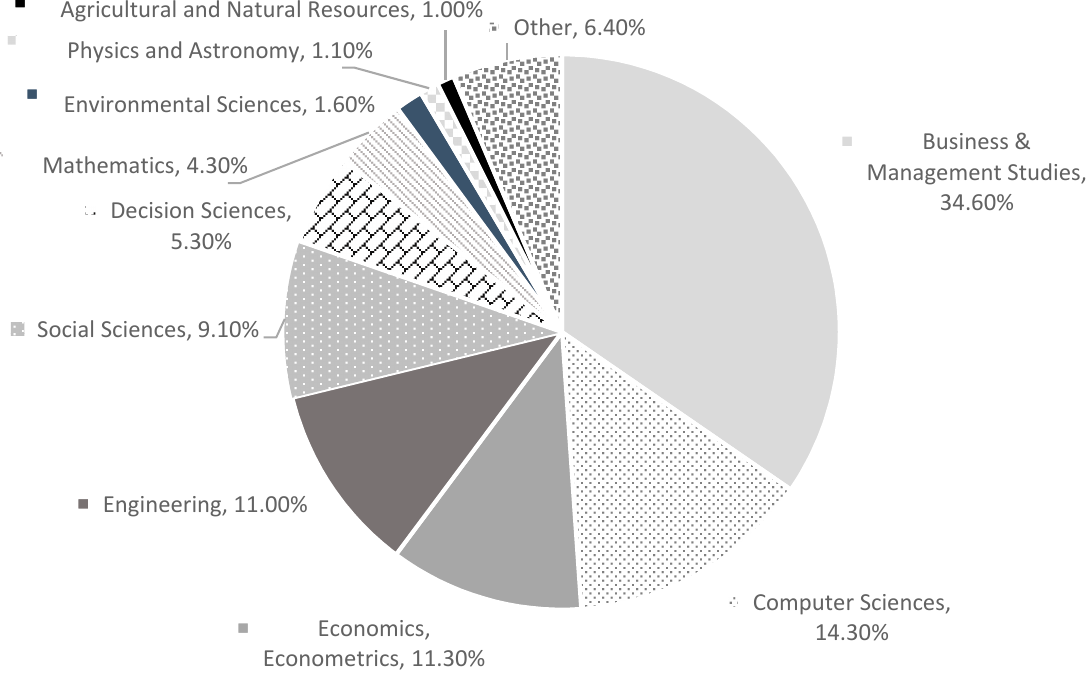
Figure 1. Papers in the field of “coopetition” classified by field (Scopus Database).